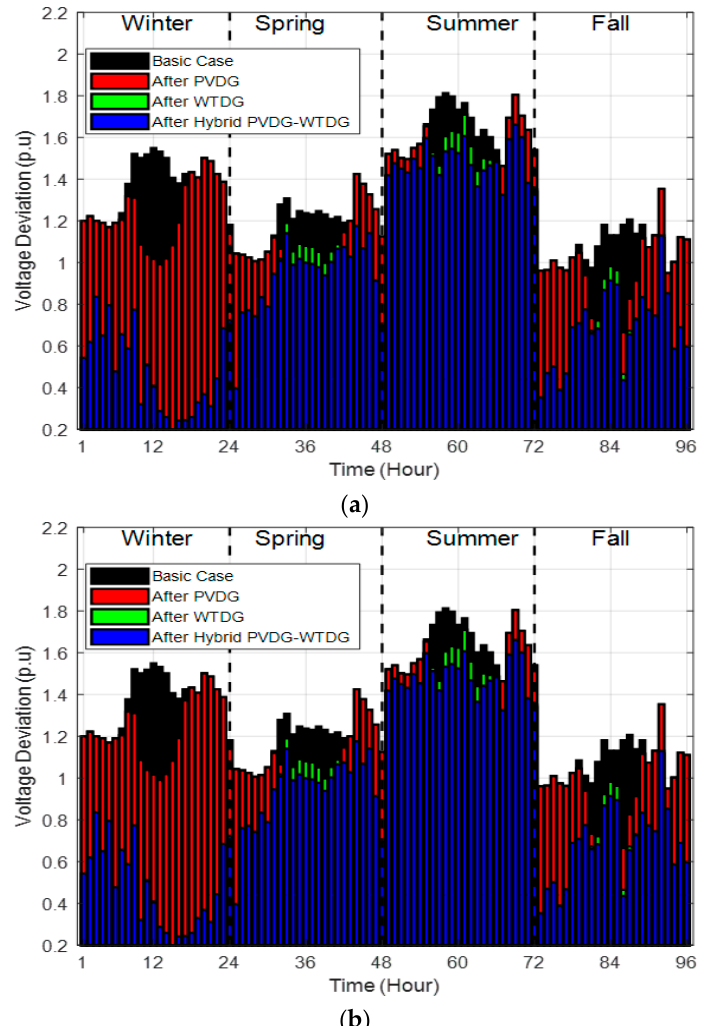
Figure 13. The seasonal total voltage derivation variation: ( a ) IEEE 33-bus; ( b ) IEEE 69-bus.